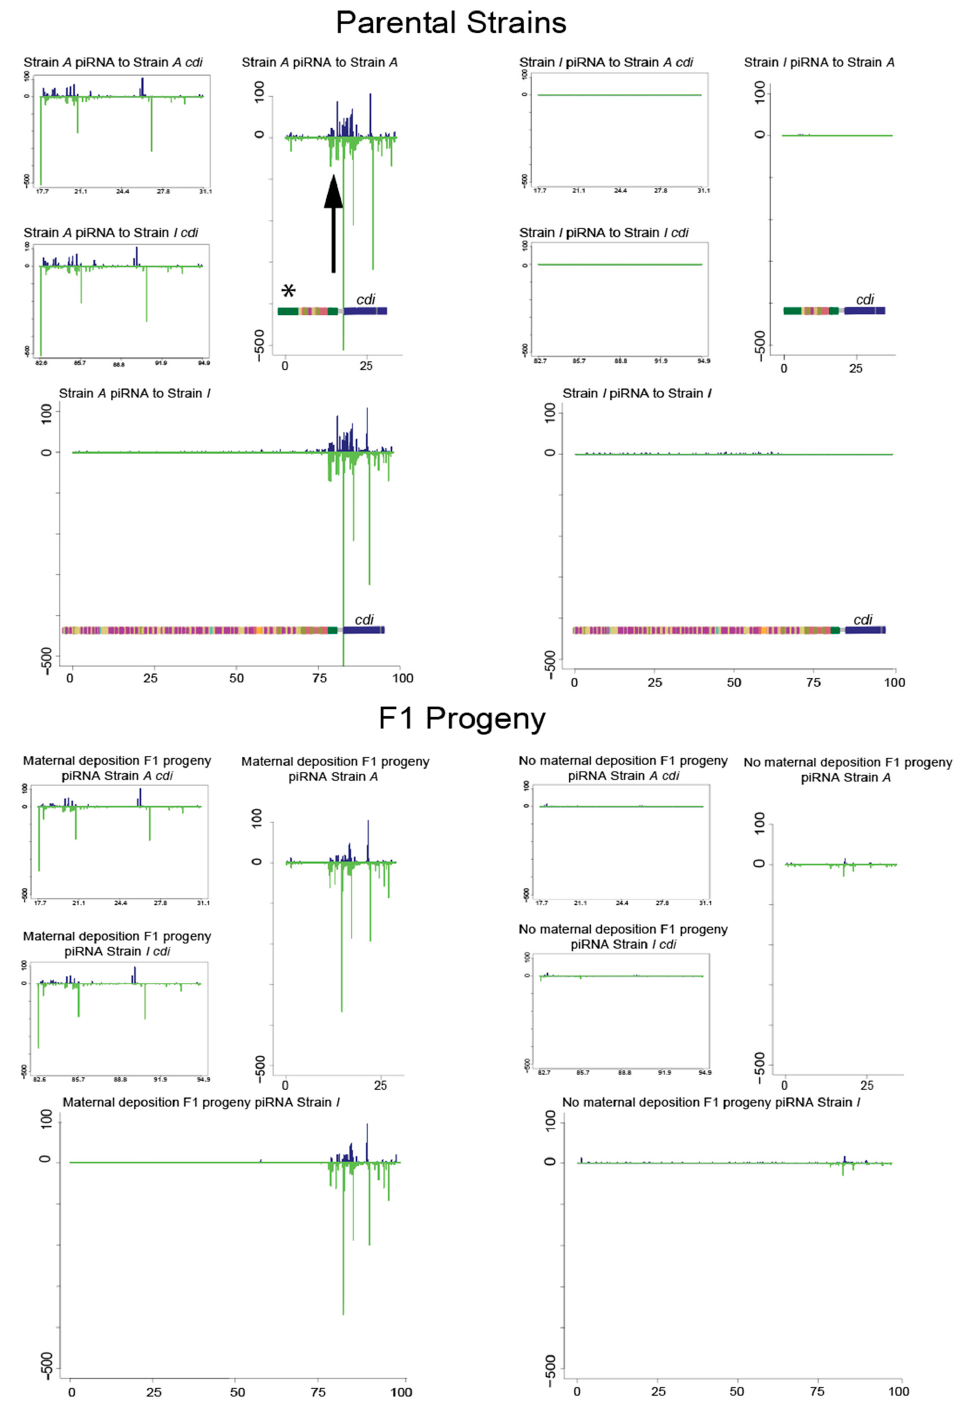
Figure 3. piRNA mappings to unique assemblies. Denoted in the top section are assembly repeat regions of cdi and distal sequence. * indicates a fragment of the TART element that is a putative assembly artifact, but shown for completeness. piRNA mappings—from within a strain and also across to the other strain—are shown for pure parental strains in top panel, with a closeup on cdi in smaller panels, upper left of each section. The arrow indicates piRNA mapping to the TART fragment just immediately flanking cdi . In F1 progeny, the layout is the same as above for parental strains, but piRNAs were mapped to both assemblies at the same time. Despite a different structure of the distal repetitive sequences, there is not abundant piRNA mapping to this satellite array. This long satellite array may function as a buffer from the piRNA-mediated regulation of the telomere